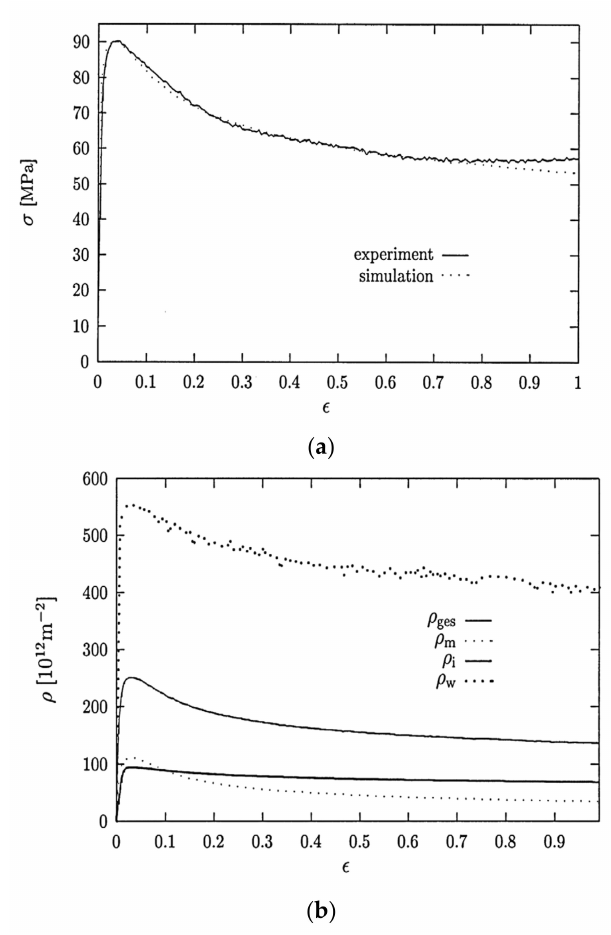
Figure 18. Predictions of the stress–strain curve and the associated dislocation evolution in Al-4.16 wt% Cu-1.37% Mg during compression at 350 ◦ C with a strain rate of 10 − 3 s − 1 . ( a ) Experimental (dots) and predicted (solid line) stress–strain curve. ( b ) Predicted dislocation density evolution, where ρ ges , ρ ρ ρ m , w represent the total dislocation density, mobile dislocation density, immobile dislocation i and density in cell interiors and immobile dislocation density cell walls, respectively (Reproduced with permission from Elsevier